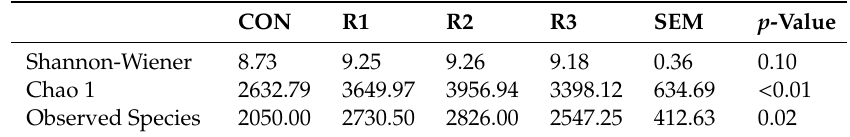
Table 2. Alpha diversity indices of rumen microbial communities in goats fed with corn and ramie, calculated from 7229 sequences ( n = 4) *.